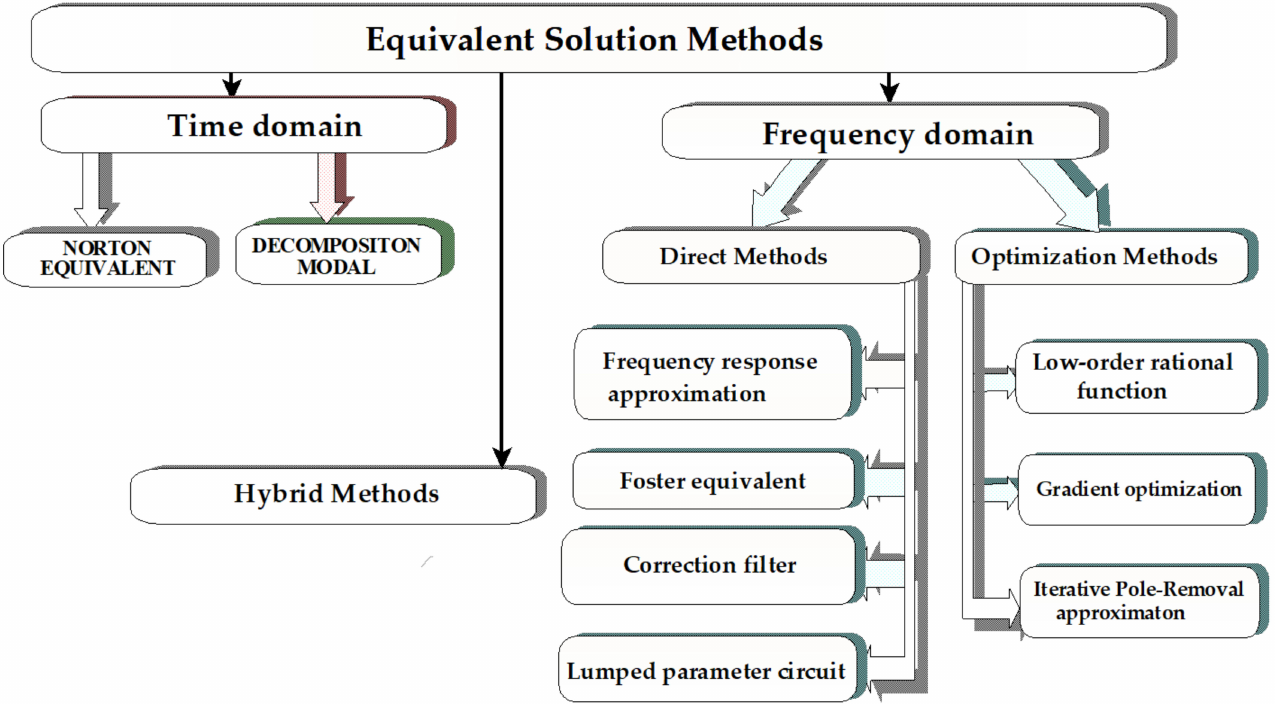
Figure 2. Review of methods for searching for